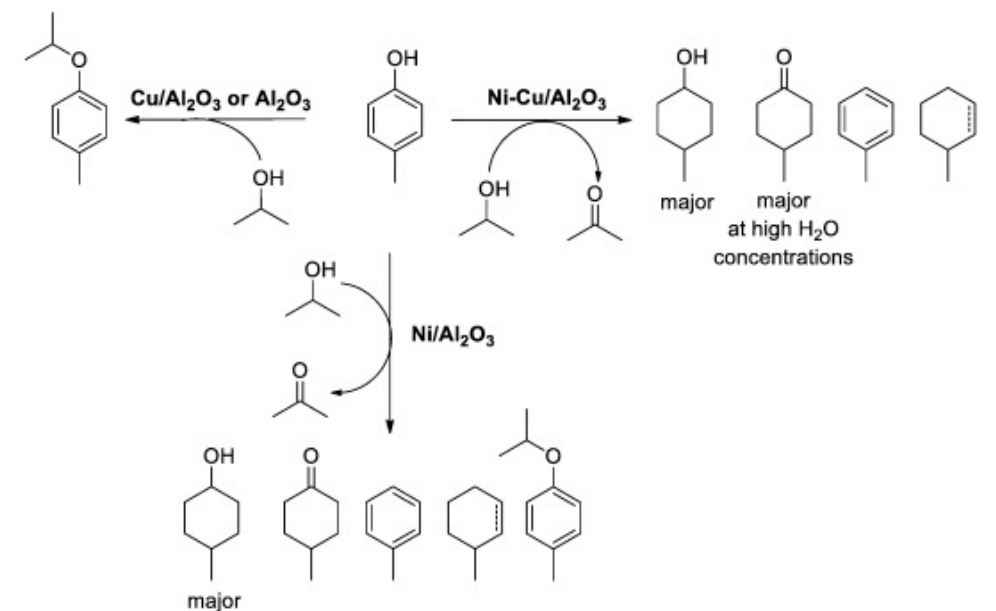
Figure 14. Transfer hydrogenation of p-cresol using isopropanol over Al 2 O 3 , Ni, Cu, and NiCu/Al 2 O 3 [68] .